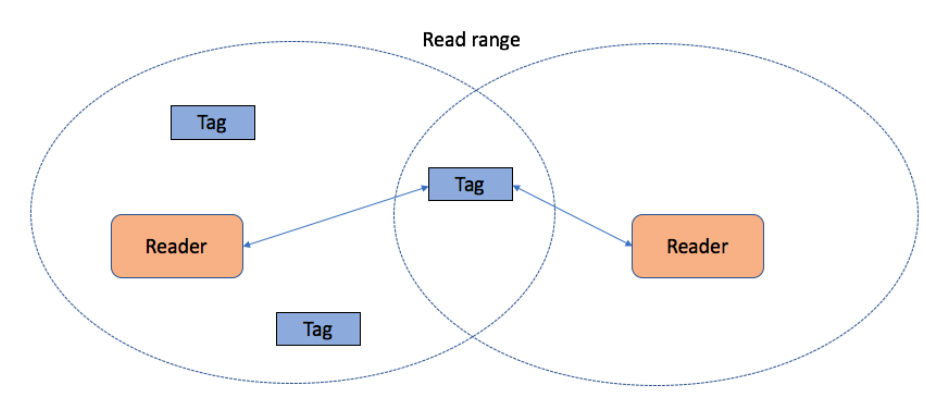
Figure 1. Reader collision.